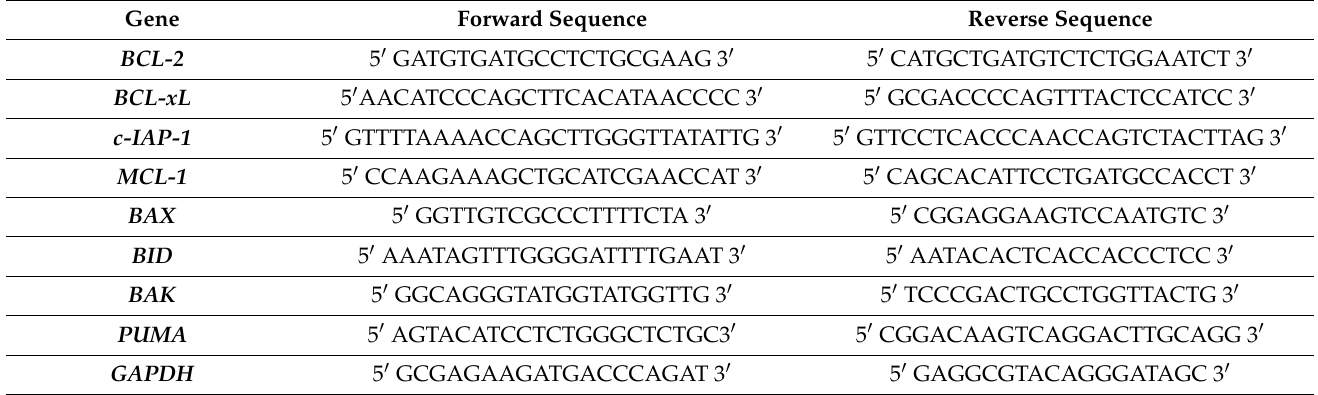
Table 1. List of primers used for